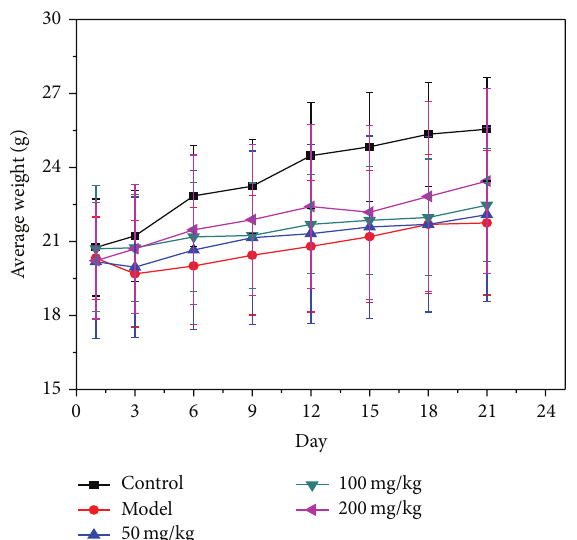
Figure 1: The effect of BBE on the body weight of STZ-induced diabetic mice.